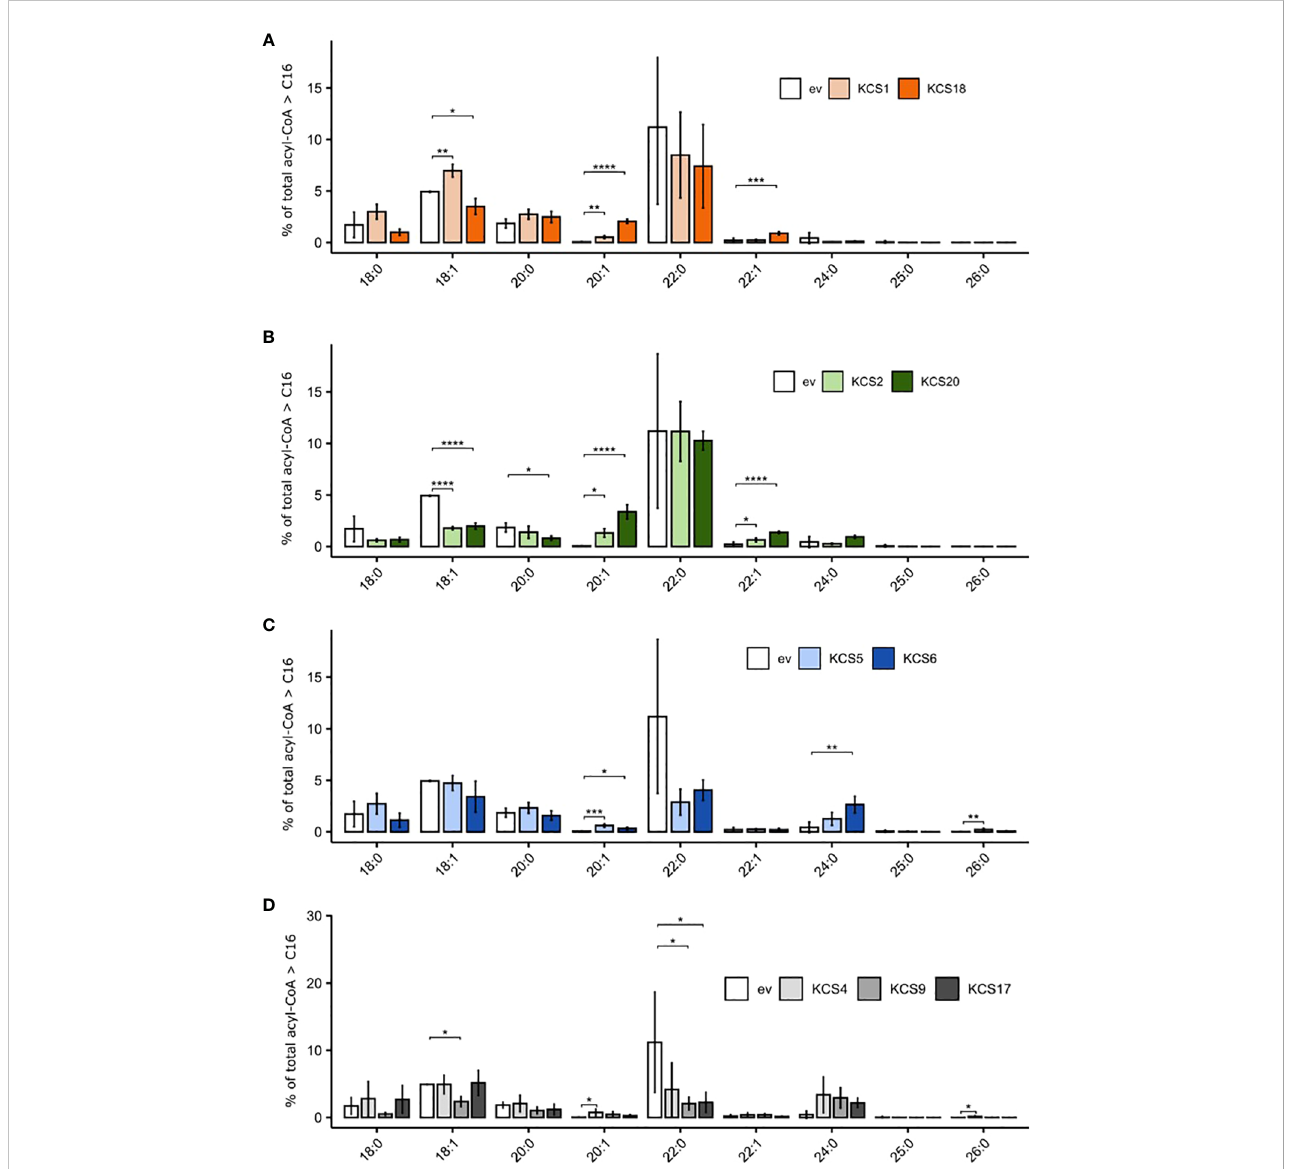
FIGURE 4 Comparison of acyl-CoA pro fi les of TRIPLE D elo3 strain (transformed with empty vector, ev) and TRIPLE D elo3 strain transformed with different AtKCS. (A) KCS1 and 18 (B) KCS2 and 20 (C) . KCS5 and 6 (D) KCS4, 9 and 17. Mean values (percentage of total acyl-CoA > or = C16) are given with SD (n = 3 to 5). Each acyl-CoA species is designated by carbon chain length and degree of unsaturation. Signi fi cance was determined with a Tukey post hoc test (*P < 0.05, **P < 0.01, ***P < 0.001, ****P < 1e -4